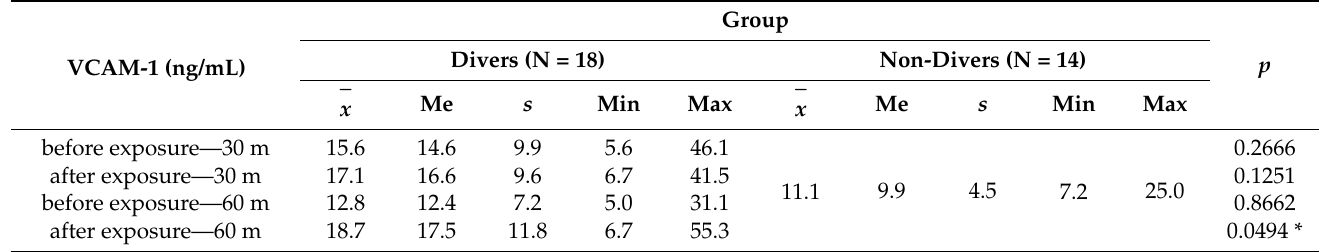
Table 6. Values of descriptive statistics characterizing the distribution of VCAM-1 in the compared groups.